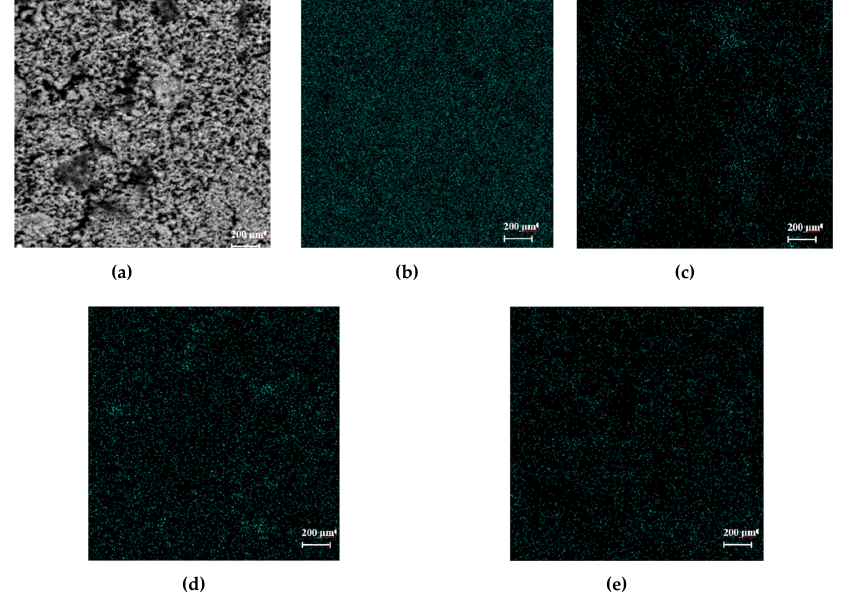
Figure 2. SEM micrograph of sintered sample with element distribution. ( a ) micrograph; ( b ) V distribution; ( c ) Cr distribution; ( d ) Ti distribution; ( e ) O distribution.